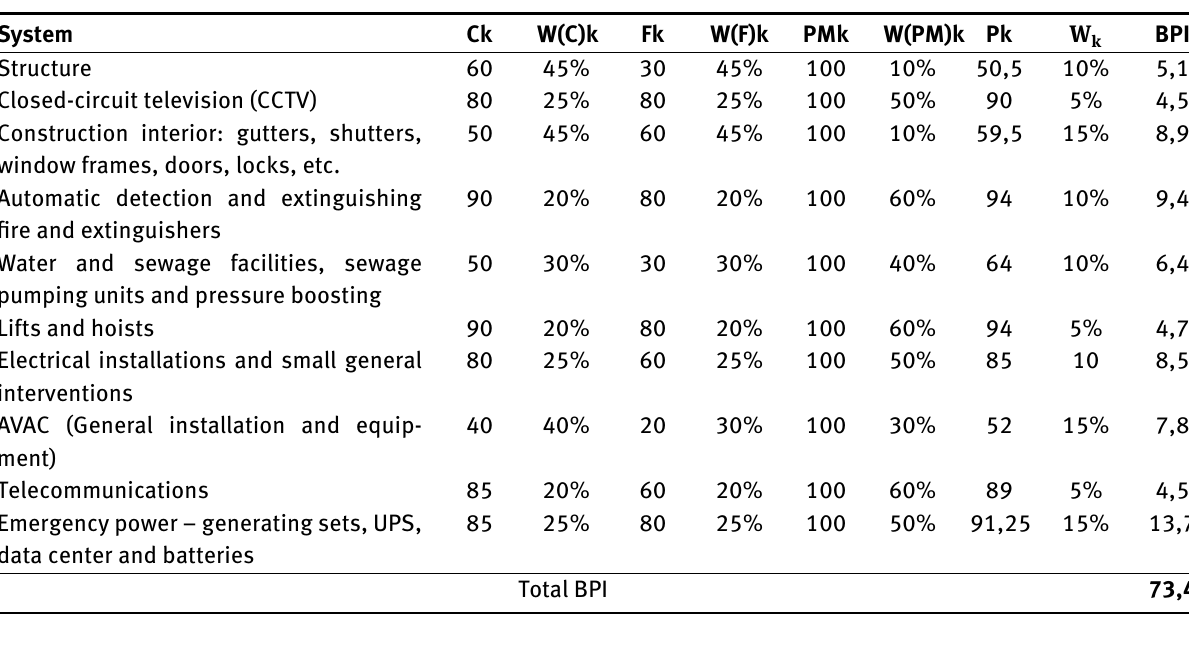
Table 7: BPI results categories (adapted from Shohet [14]).